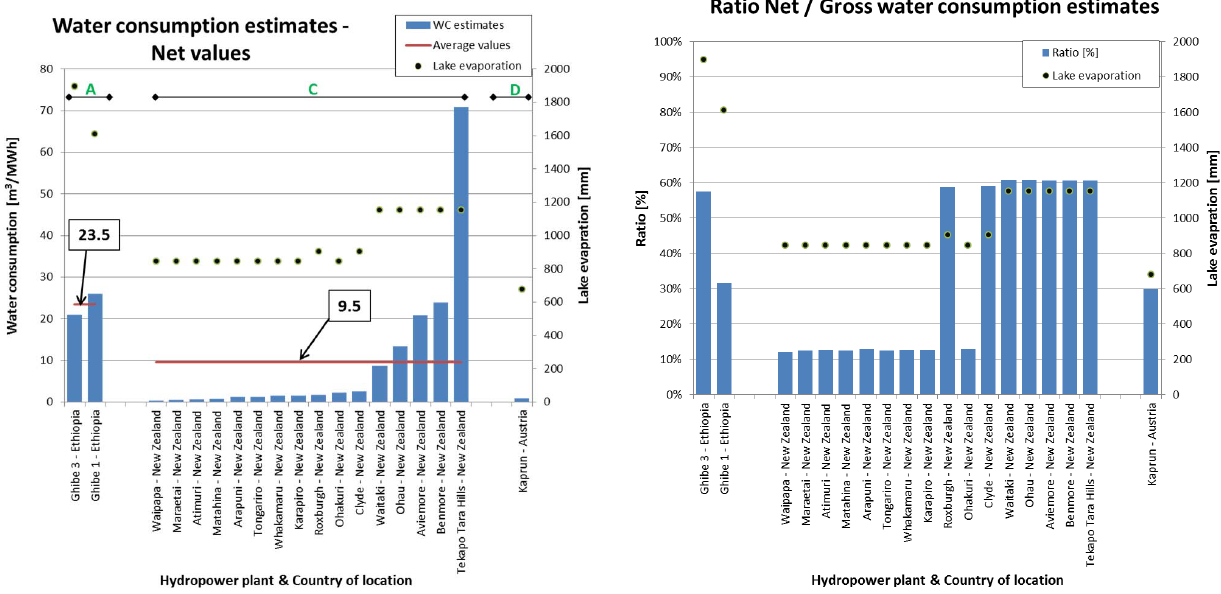
Fig. 2. The left panel of the figure presents net water consumption estimates and evaporation rates for individual plants. The number tags are arithmetic averages of water consumption. The right panel presents the differences (ratio net/gross, given in %) in water consumption rates for those individual plants with both net and gross water consumption